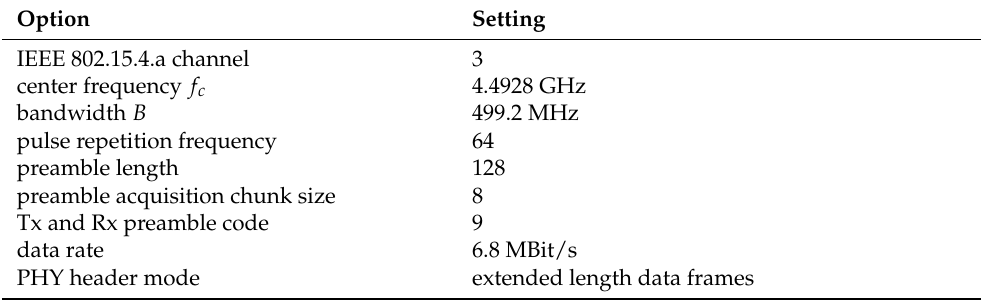
Table 1. RF settings of the Decawave DW1000 radio chip.